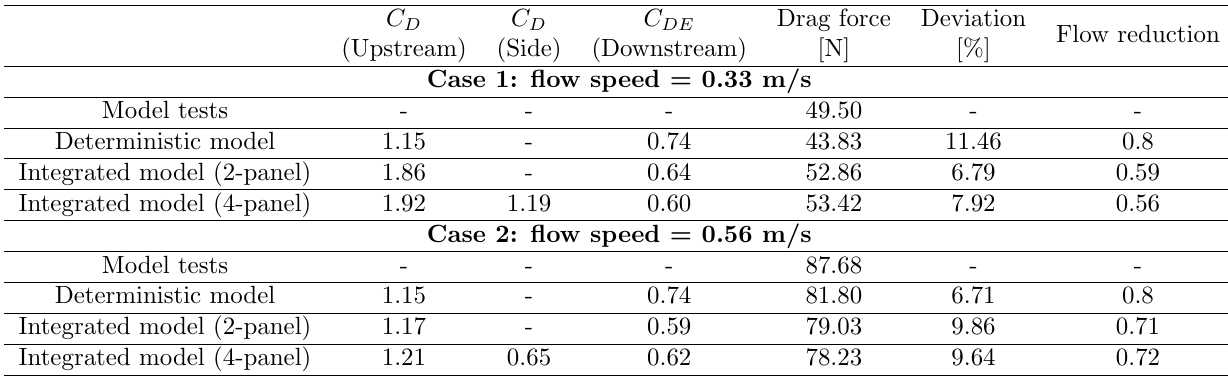
Table 4: Summary of the hydrodynamic parameters and fluid forces of model tests Lader and Enerhaug (2005) and numerical